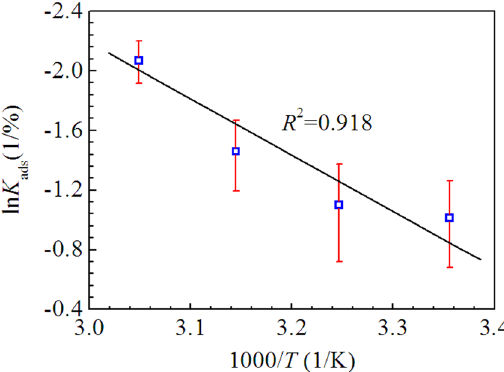
Figure 6. The relationship between ln K ads and (1000/ T ) for mild steel in 0.5 M H 2 SO 4 solution containing LLE.